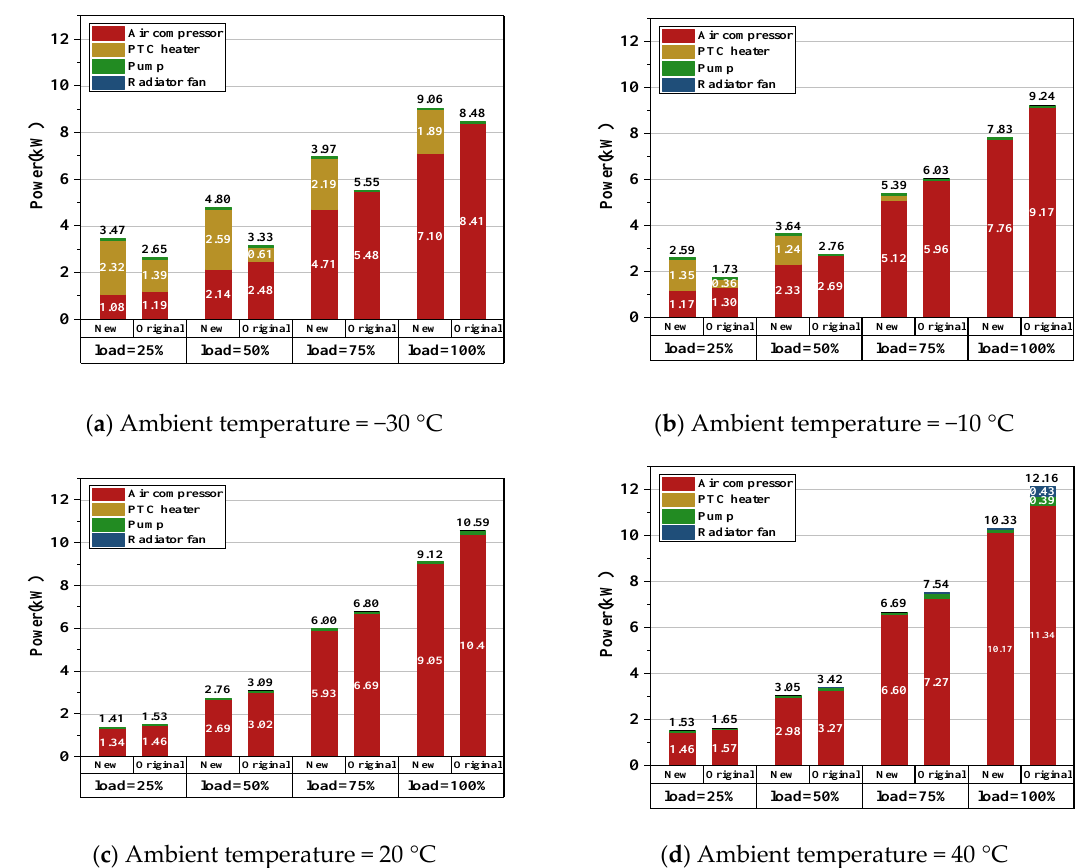
Figure 11. System parasitic power consumption. ( a ) Ambient temperature = −30 °C; ( b ) Ambient temperature = −10 °C; ( c ) Ambient temperature = 20 °C; ( d ) Ambient temperature = 40 °C.